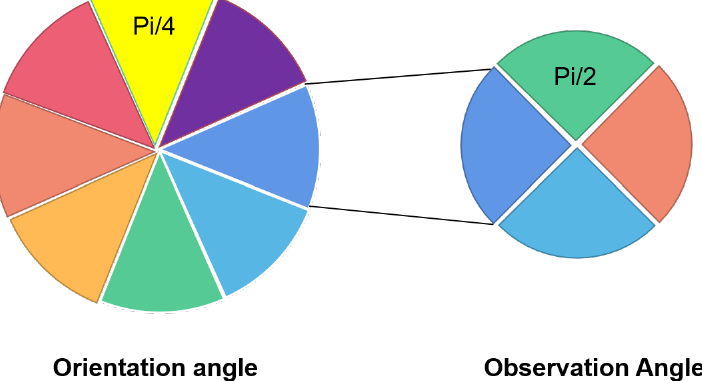
Figure 4. Orientation angle and observation angle are selected as the factors for classification. The orientation angle is divided into N parts, and the observation angle is divided into M parts. The total number of categories is N × M